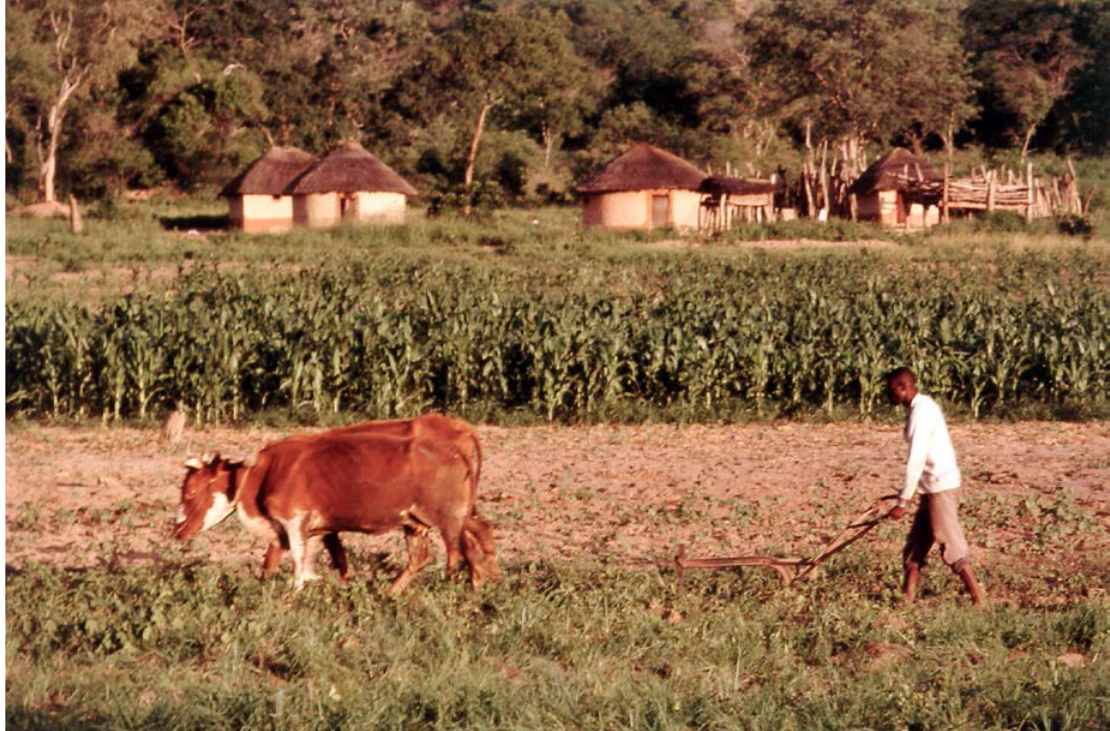
Figure 2. A typical homestead and livelihood activity in the study area (photo: James Butler).